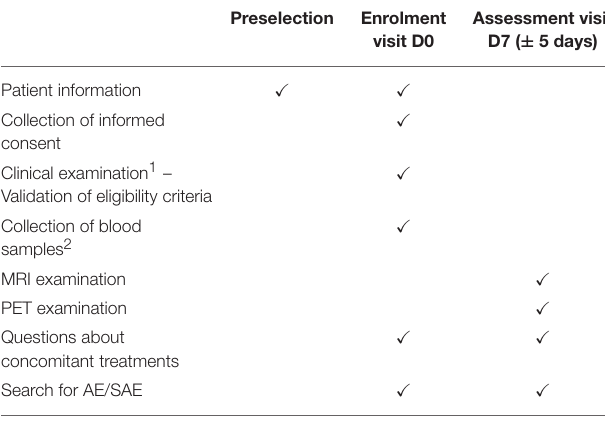
TABLE 1 | Summary of INFLADEP